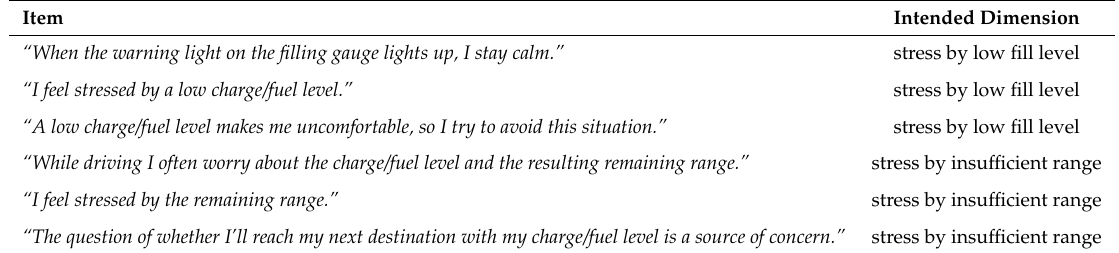
Table A2. Question items adapted from [21] to measure stress by a low fill level and by an insufficient range. Item Intended Dimension “When the warning light on the filling gauge lights up, I stay calm.” stress by low fill level “I feel stressed by a low charge/fuel